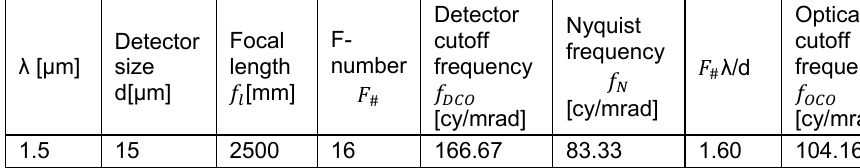
Table 3 – Calculated cutoff frequencies for the SWIR camera